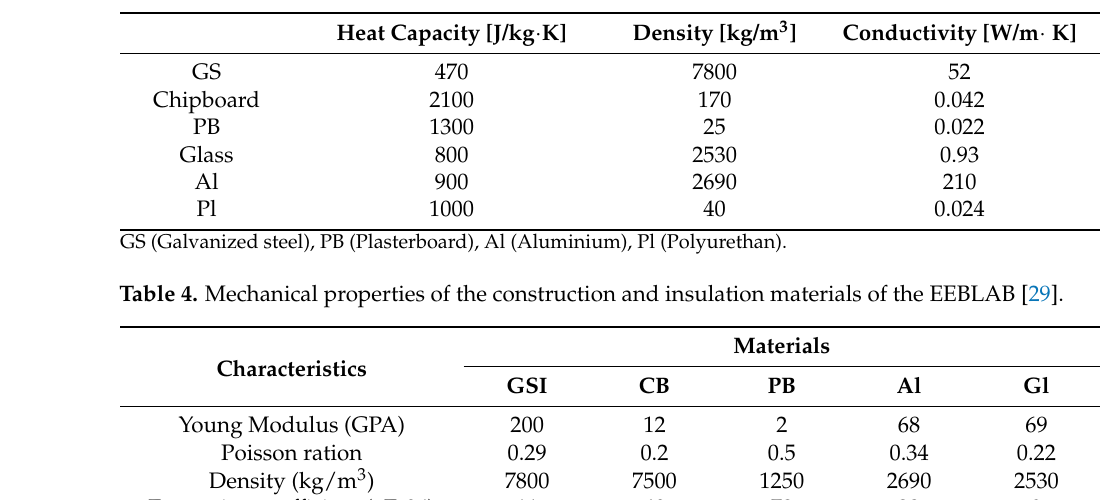
Table 3. Thermal properties of the construction and insulation materials of the EEBLab [29].